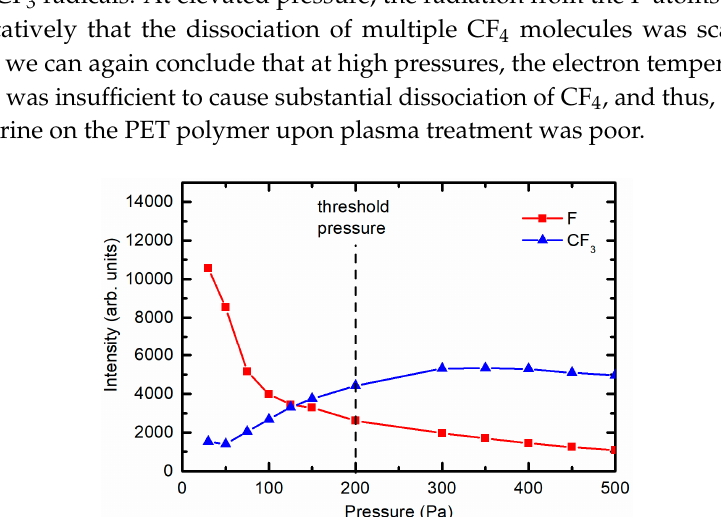
Figure 9. OES spectra of CF 4 plasma at various pressures: ( a ) below the threshold pressure and ( b ) above the threshold pressure.